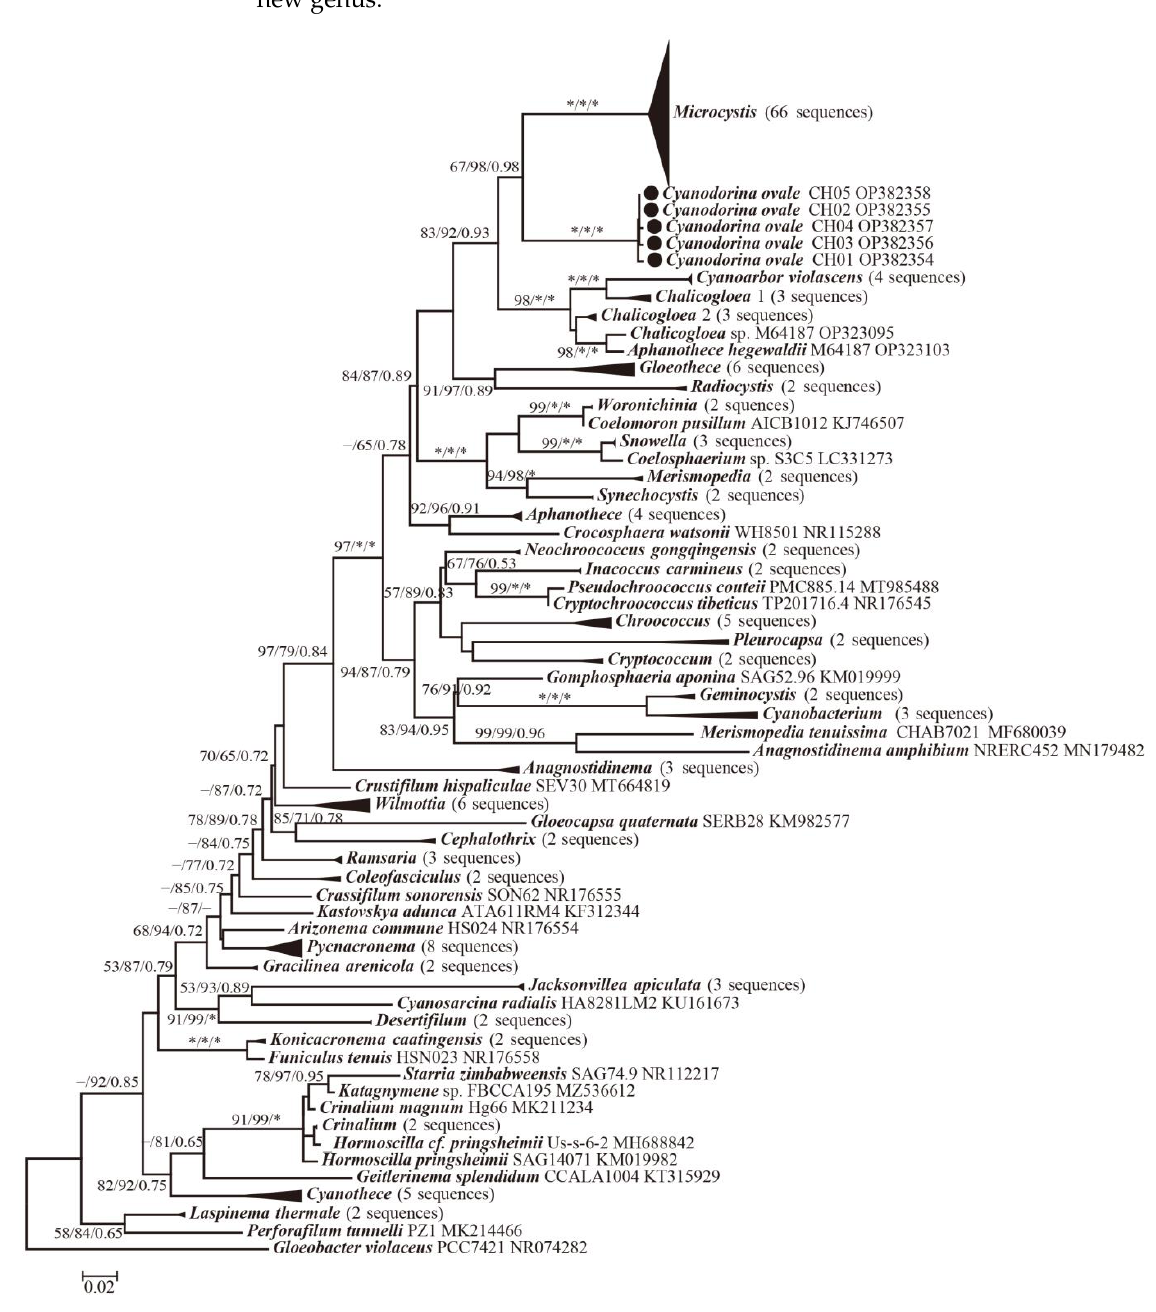
Figure 3. Maximum likelihood (ML) phylogenetic tree of cyanobacteria based on 16S rRNA sequences (1020 bp) representing the current GenBank data for Chroococcalean cyanobacteria. Bootstrap values greater than 50% are shown on the ML tree for the NJ/ML methods and Bayesian posterior probabilities. * indicates bootstrapping values of 100 for NJ, ML, and BI posterior probabilities of 1.00. Sequences from GenBank are indicated by accession numbers. The main clades are indicated by numbers. Sequences from this study are denoted with solid circles.